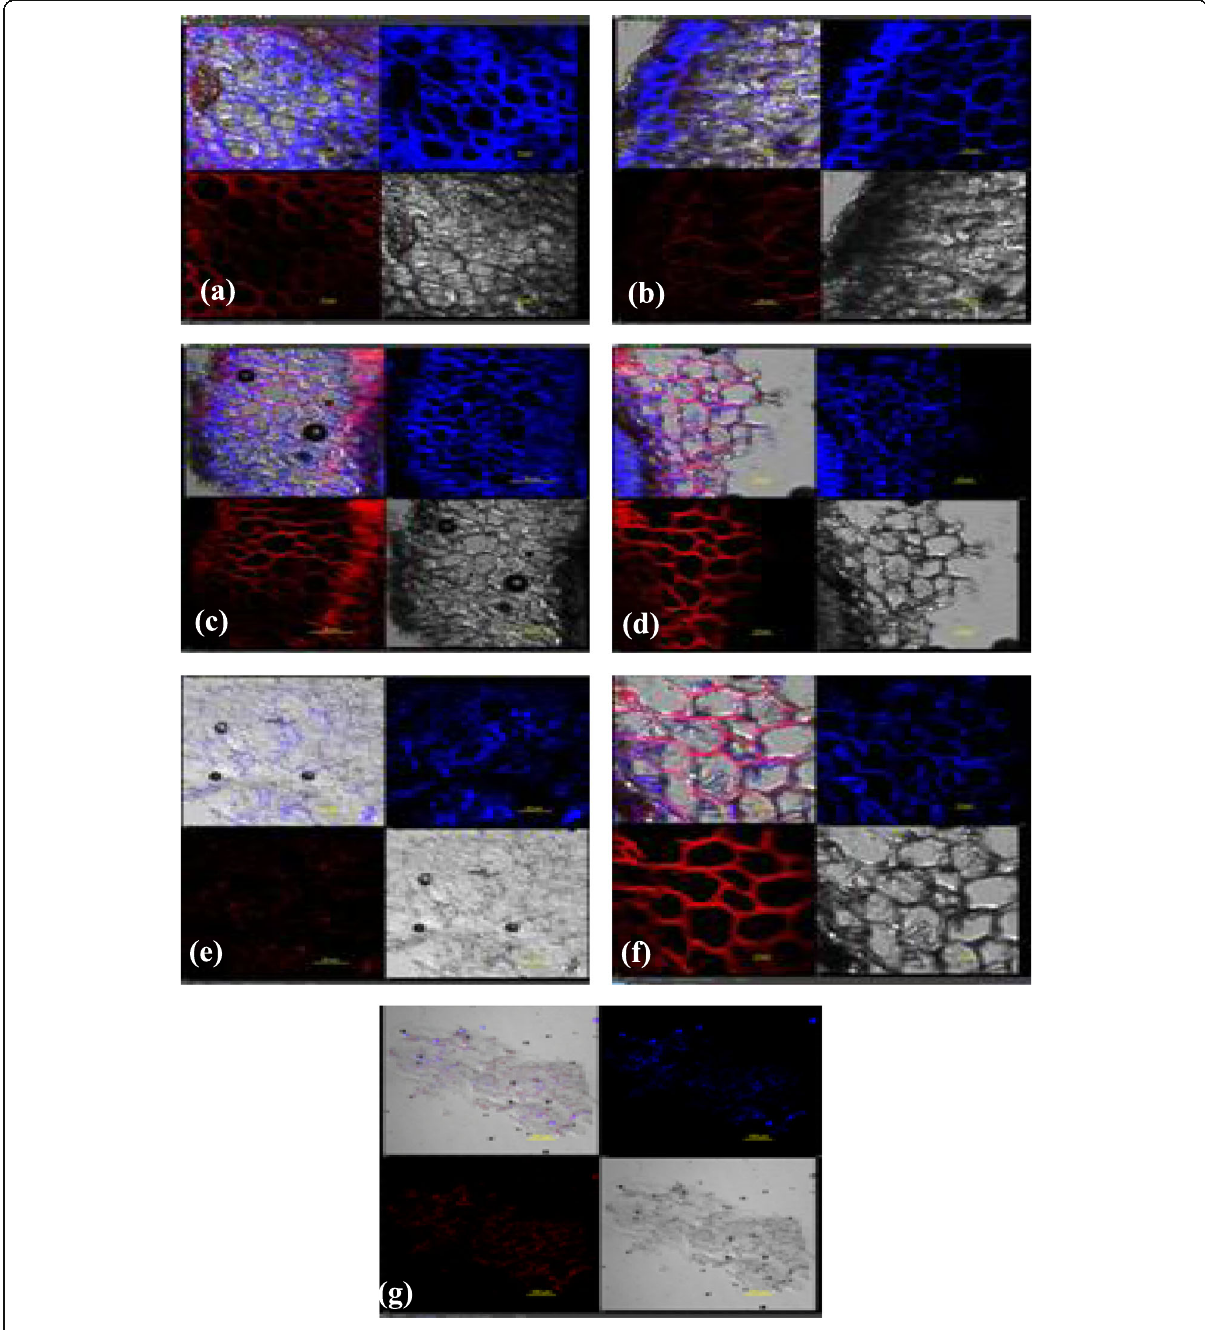
Fig. 4 Microscopic elucidation of colonized and established fungal root endophytes [ a Fusarium equiseti strain M1, b Talaromyces aculeatus strain Ap, c Neocosmospora perseae strain G, d Aspergillus aculeatus strain C2, e Crinipellis tabtim strain M8, f Fusarium circinatum strain K3, and g control] by confocal laser scanning microscopy